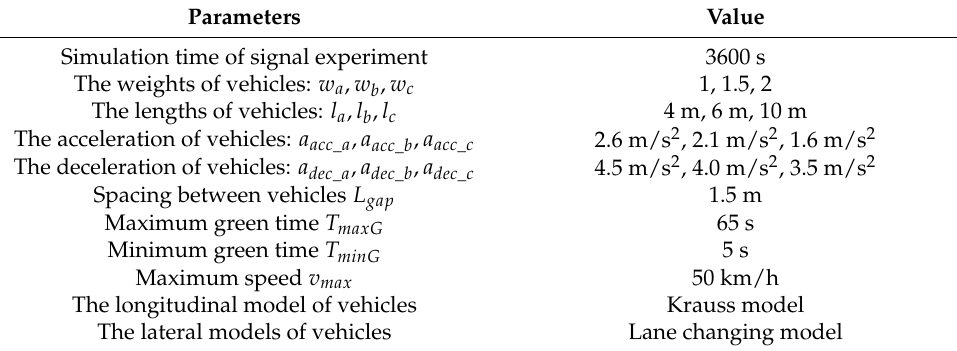
Figure 4. Vehicular traffic environment in SUMO. Table 1. The main simulation